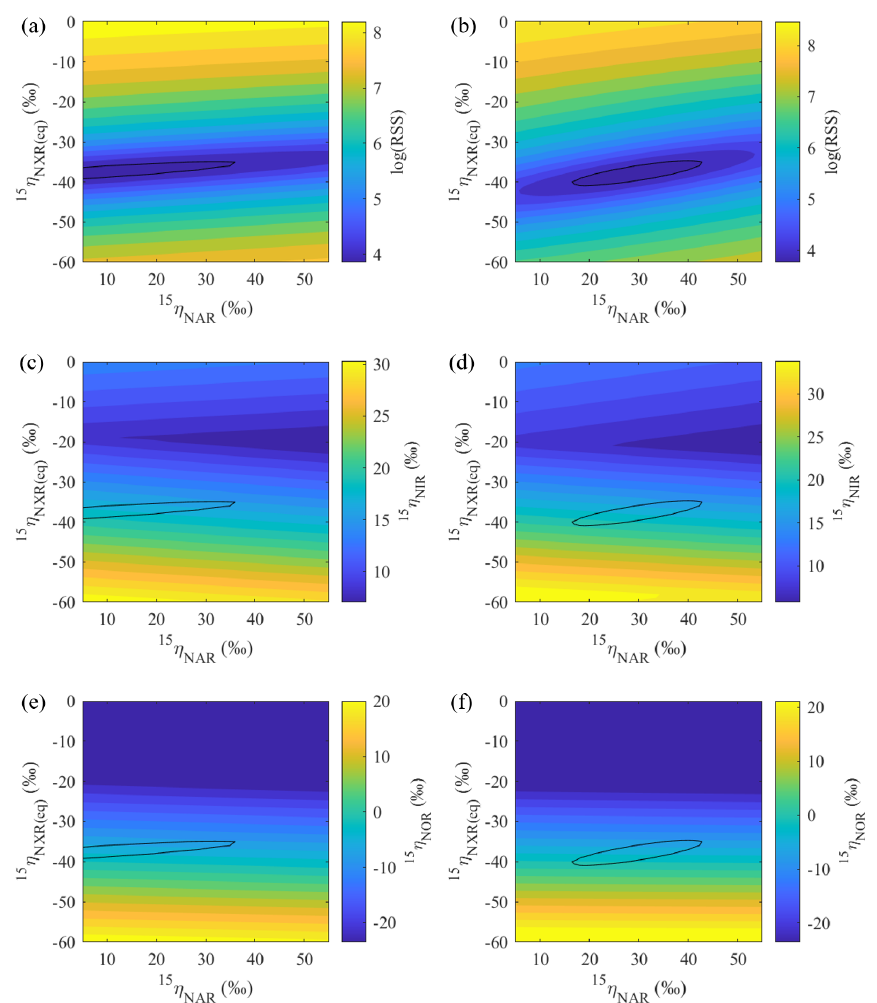
Figure 7. Contour maps showing variations in error-weighted residual sum of squares (RSS) between simulated and measured δ 15 N values, modeled 15 η NIR , and modeled 15 η NOR as a function of prescribed 15 η NAR and 15 η NXR under the no-exchange (a, c, e) and complete- exchange (b, d, f) model scenarios. Bold contour lines encompass the best-fit models defined by the lower percentile 2.5 of the error-weighted